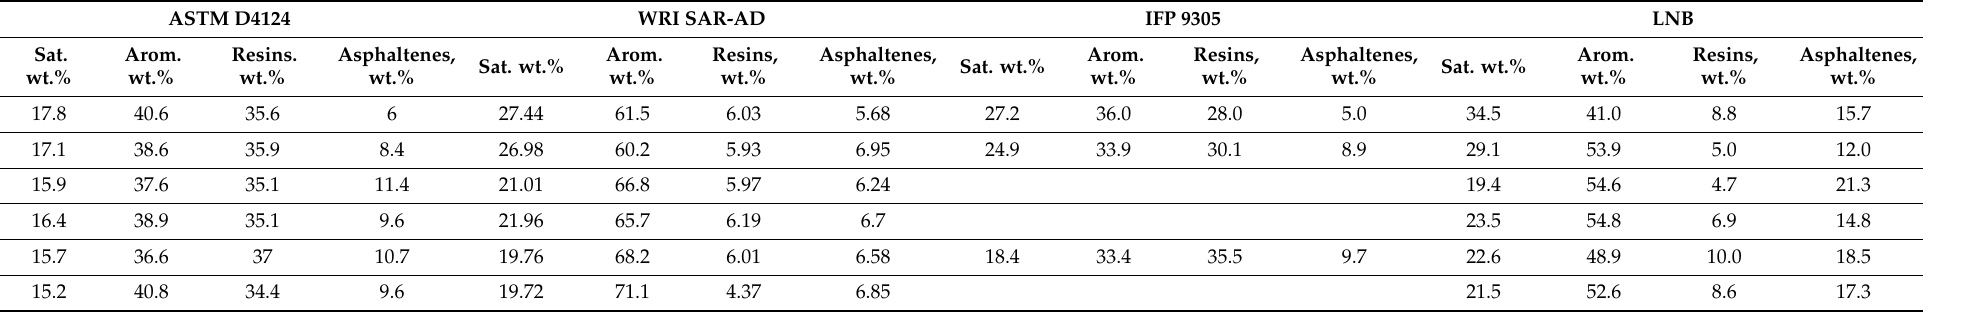
Table 3. SARA composition data of H-Oil VTBs measured by ASTM D4124 method, SAR-AD TM method, IFP 9305, and LNB Research Laboratory method. ASTM D4124 WRI